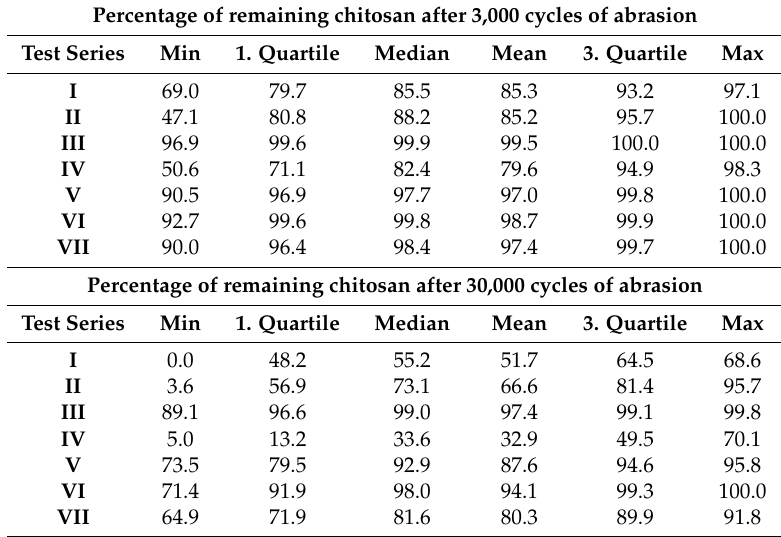
Table 5. Percentage of remaining chitosan on PMMA specimens after abrasion tests ( n = 10).